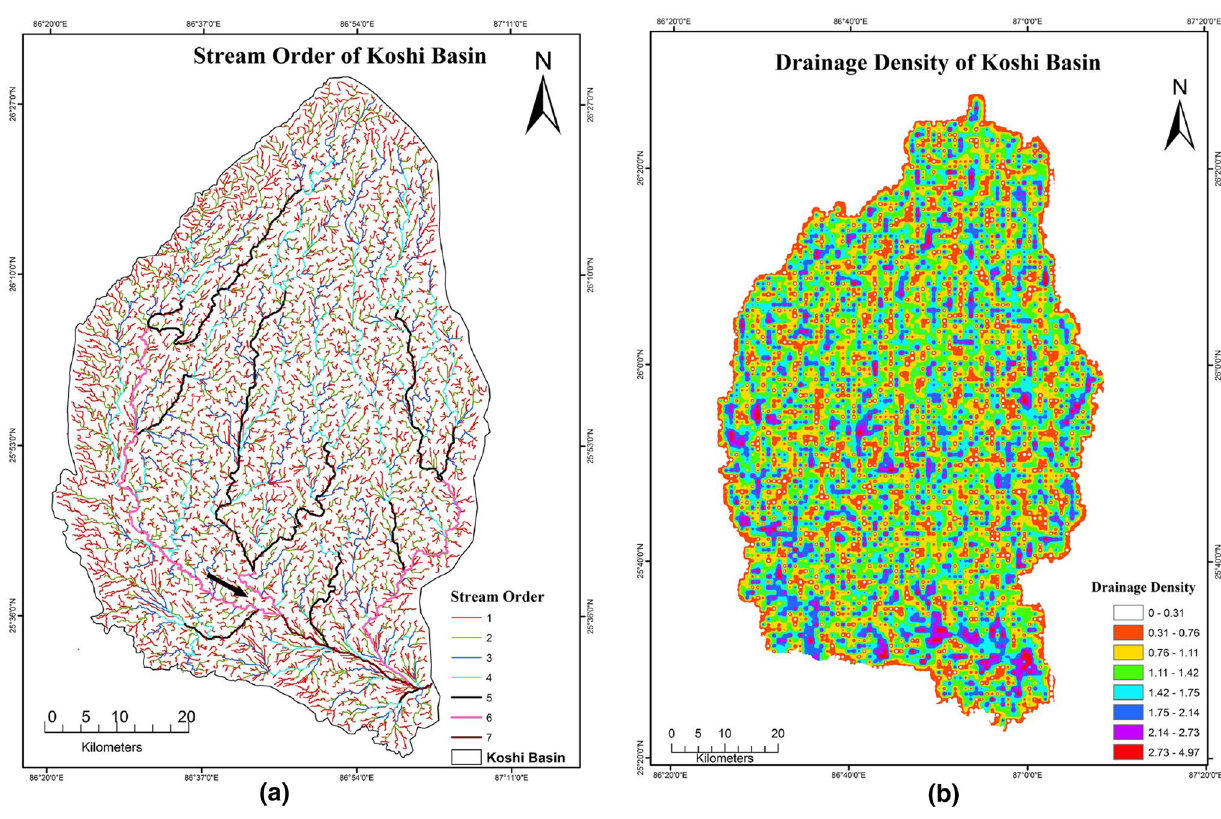
Fig. 5 Stream order ( a ) and drainage density ( b ) of the Kosi basin Table 2 Stream order, streams number, stream length and mean stream length of lower Kosi